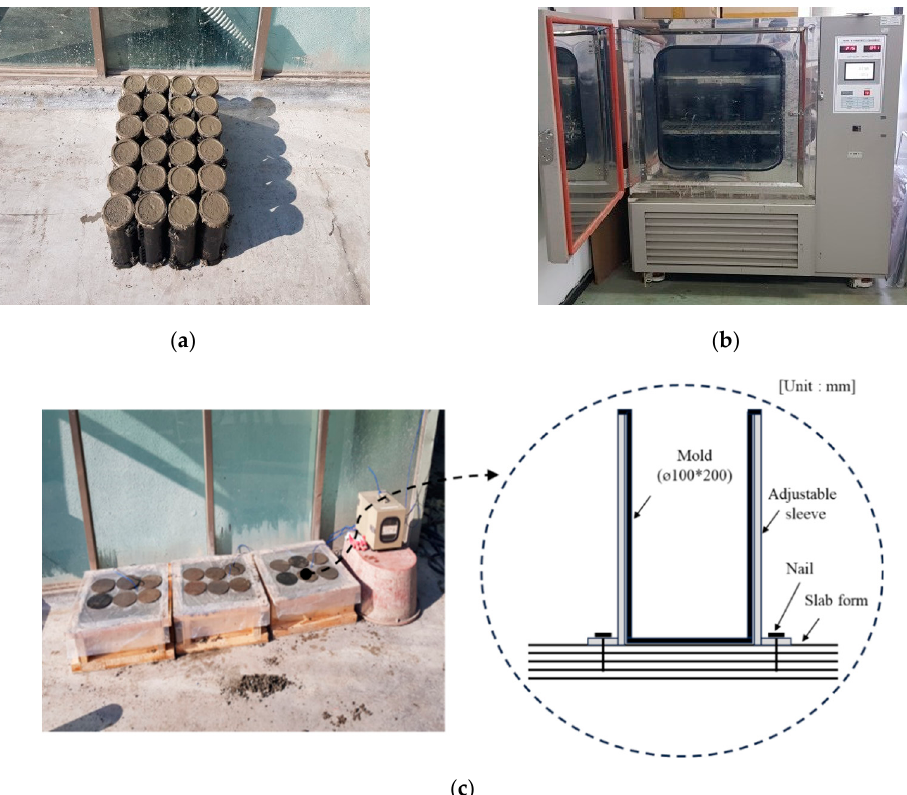
Figure 2. Photographs of concrete curing methods: ( a ) air curing; ( b ) chamber curing; ( c ) cast-in-place (slab-embedded specimens for outdoor curing).